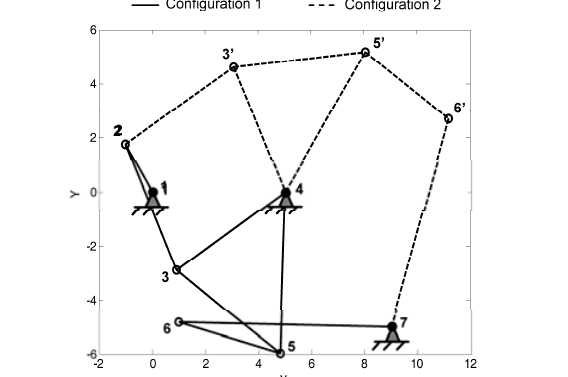
Fig. 10 Two possible configurations for the